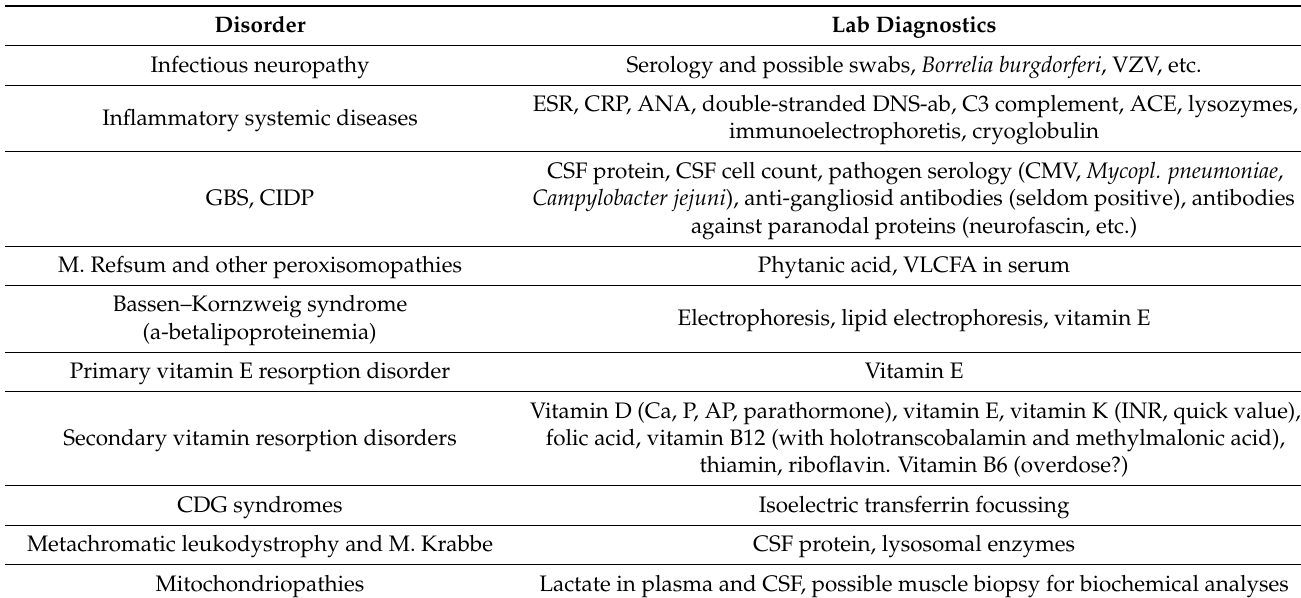
Table 3. Laboratory tests for clinically and electrophysiologically suspicious